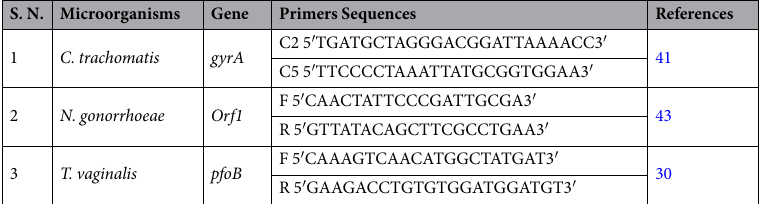
Table 1. List of primer sets specific for different pathogens used in the present study.